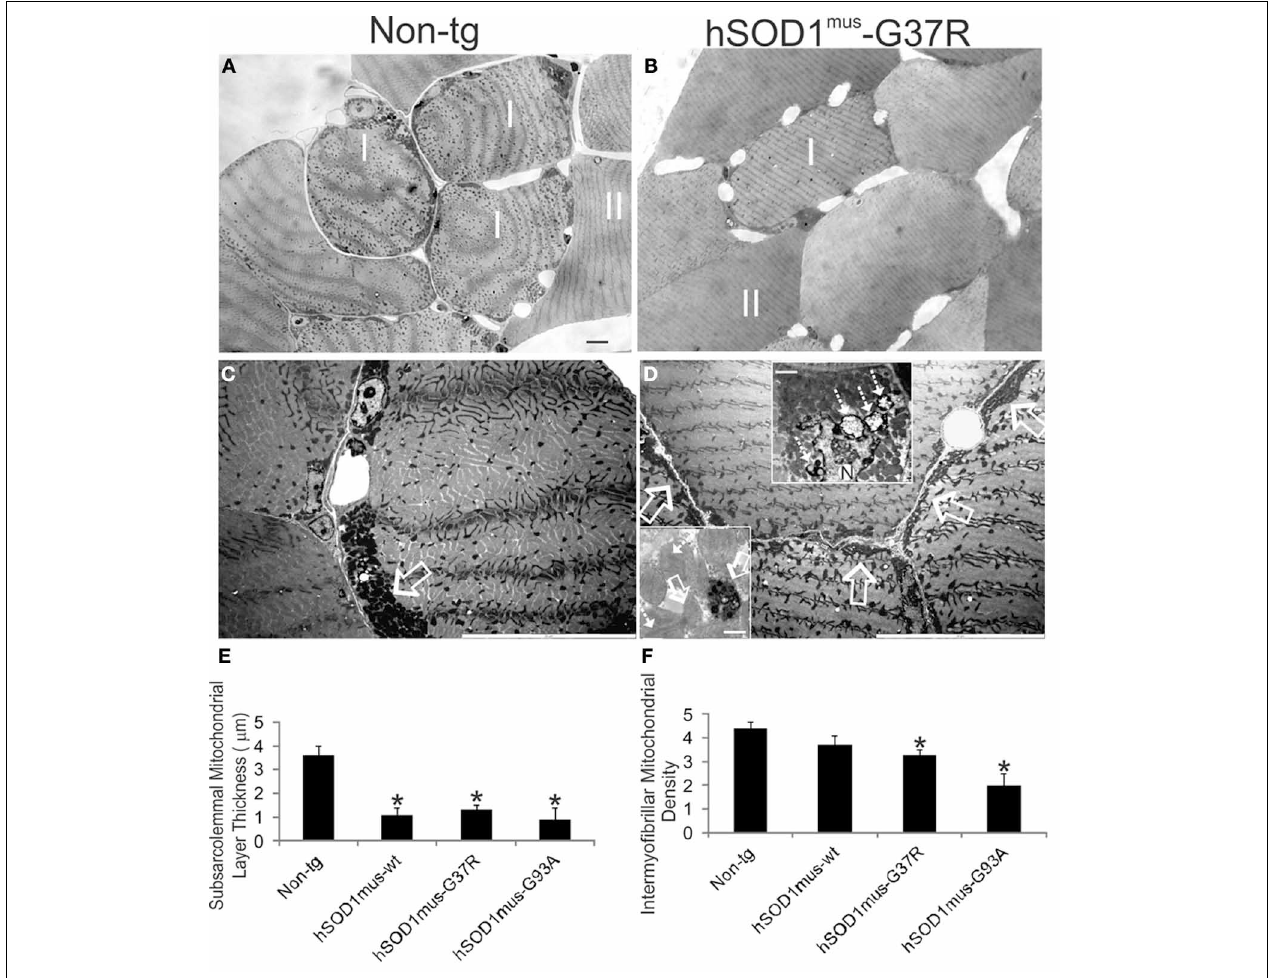
(D) shows prominent mitophagy of subsarcolemmal mitochondria (hatched arrows) by a myonucleus (N) in hSOD1 mus -G37R tg mouse skeletal muscle. Scale bar = 1.3 µ m. Lower inset (D) shows degenerating mitochondria with round inclusions (open white arrows) or rod inclusions (hatched white arrows) from hSOD1 mus -G93A tg mouse skeletal muscle. Scale bar = 0.5 µ m. (E) Graph of the thickness of type I fiber subsarcolemmal mitochondrial layers in age-matched ( ∼ 17 months) non-tg and hSOD1 mus tg mice. Values are mean ± SD. Asterisk denotes significant differences ( p < 0 . 01) from non-tg control. (F) Graph of type II fiber interfibrillar mitochondrial densities in age-matched ( ∼ 17 months) non-tg and hSOD1 mus tg mice. Values are mean ± SD. Asterisk denotes significant differences ( p < 0 . 01) from non-tg